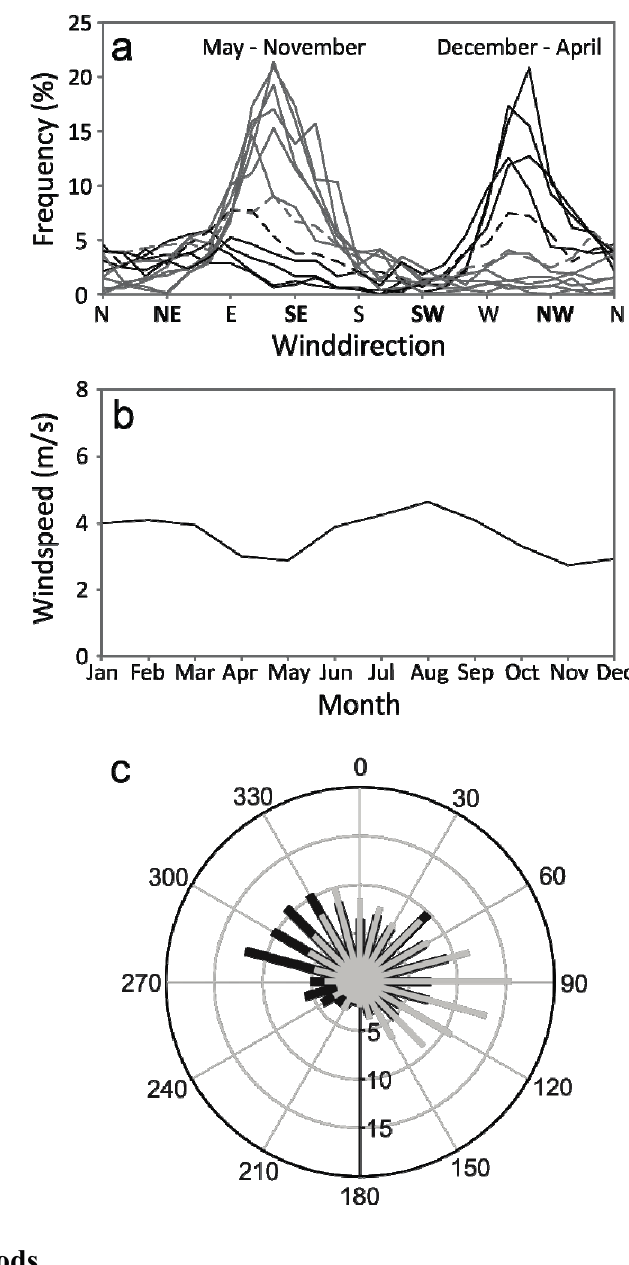
Figure 3. Climatic and hydrodynamic conditions for the area around Takú Atoll (156°E, 5°S). ( a ) Mean percent frequency of yearly wind directions for all months since 1991. Dashed lines represent April (black) and November (grey). ( b ) Mean annual wind speed. ( c ) Mean percent frequency of surface current direction since 1999 for May-November (black) and December-April